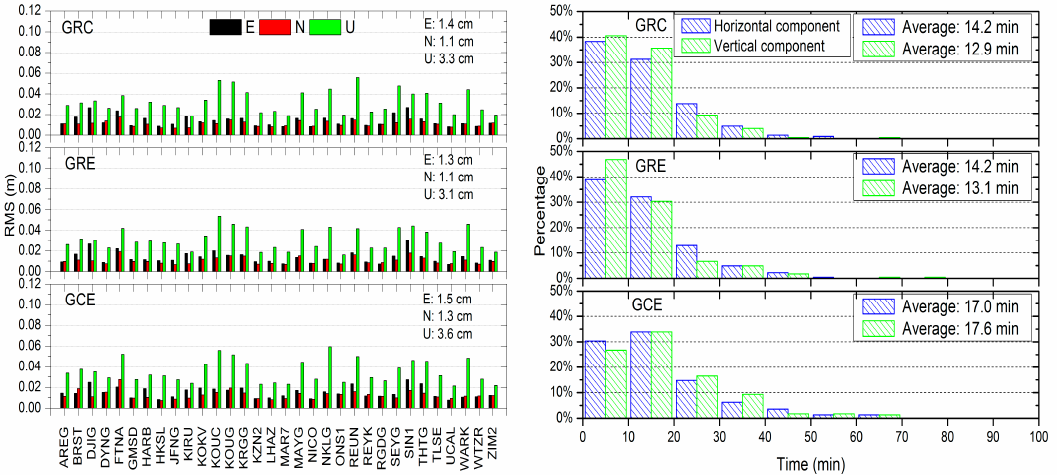
Figure 10. The positioning RMS of the triple-system combined PPP in east, north, and upward coordinate components ( left ), and the convergence time statistic of the triple-system combined PPP in the horizontal and vertical components ( right ).